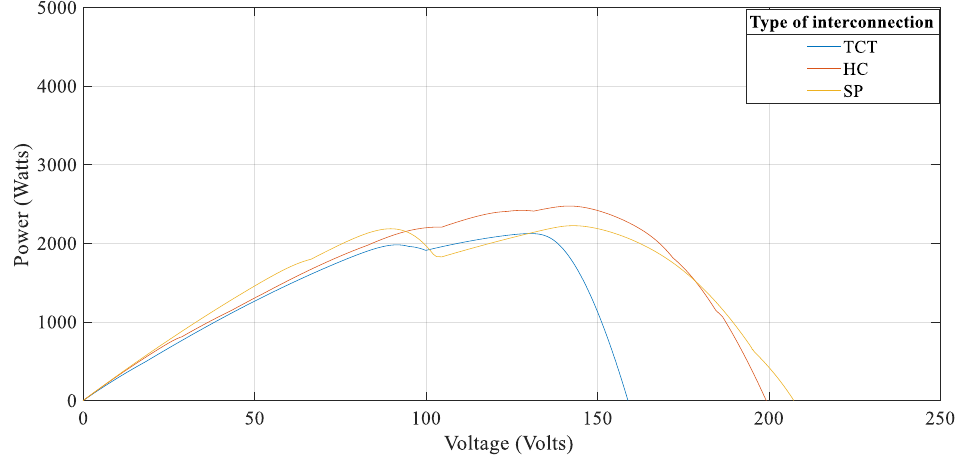
Figure 14. P-V curve for multiple faults ‘F4′ (thin-film PV).